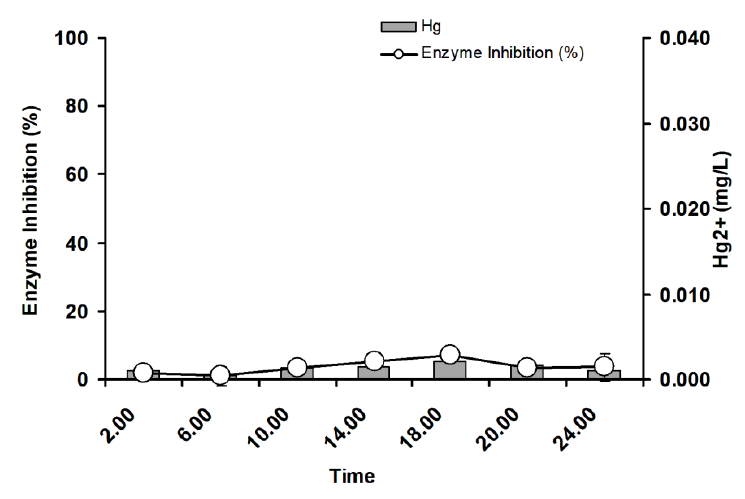
Figure 12. Near real-time detection of mercury in Port Klang waters using the ficin inhibitive enzyme assay. Presence of mercury was validated using FIMS. Error bars represent mean ± standard deviation ( n =